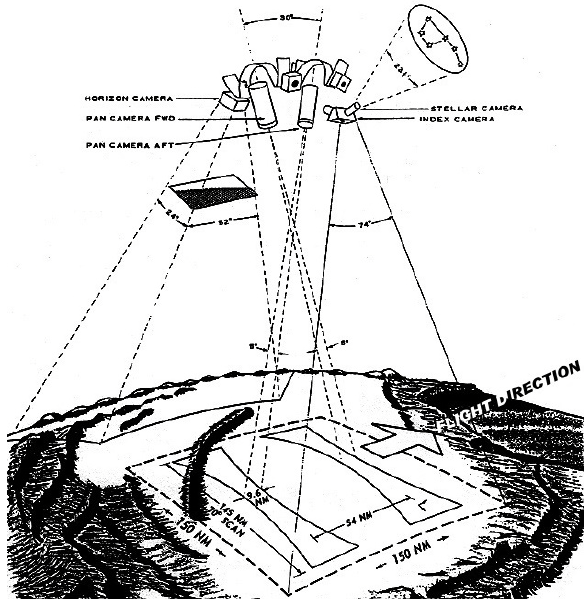
Figure 3. Corona data block